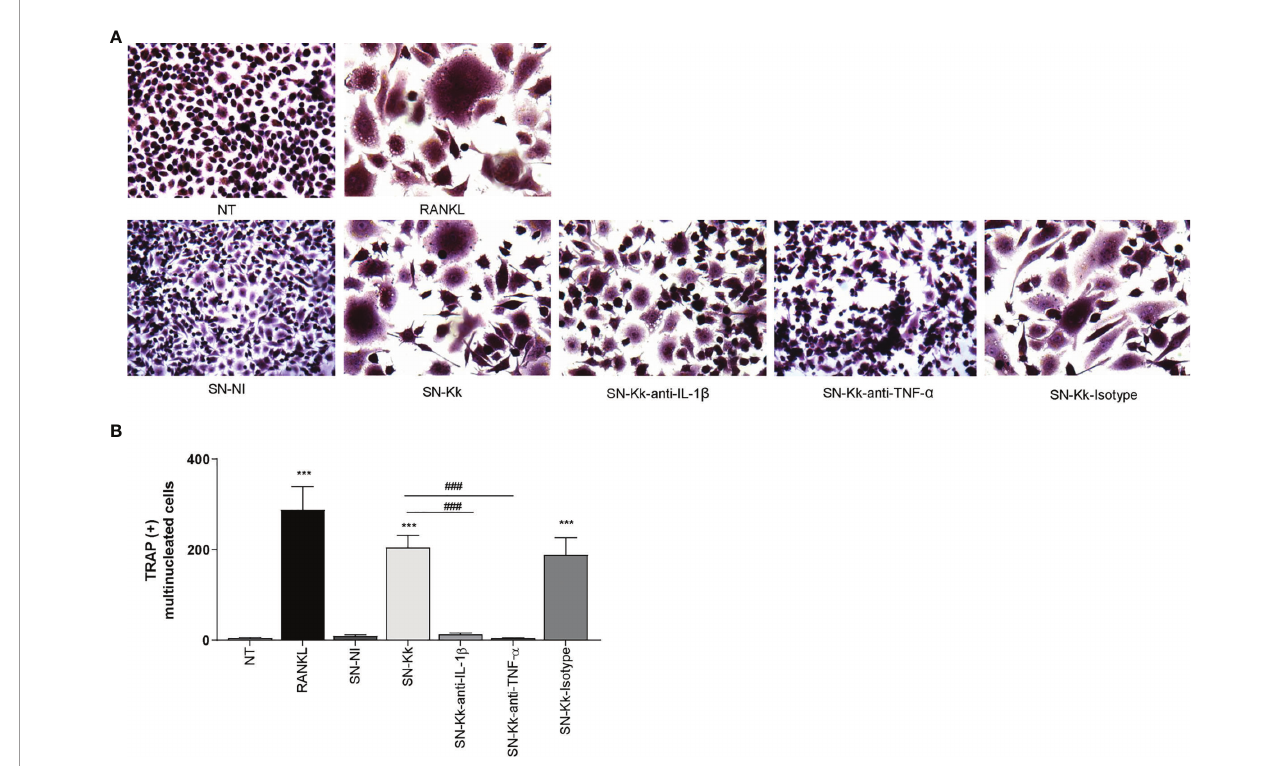
FIGURE 2 | Culture supernatants from Kingella kingae -infected monocytes induce osteoclast differentiation mediated by TNF- a and IL-1 b . Supernatants from K. kingae - infected THP-1 monocytes (multiplicity of infection = 1) induce RAW 264.7-derived osteoclastogenesis. RAW 264.7 cells were either untreated or stimulated with culture supernatants from K. kingae -infected THP-1 monocytes (SN-Kk) or with culture supernatants from non-infected THP-1 monocytes (SN-NI) added at a 1:2 proportion in conjunction with macrophage colony-stimulating factor. To inhibit TNF- a and IL-1 b , experiments were conducted in the presence of neutralizing antibodies. After 7 days, osteoclastogenesis was determined by the generation of TRAP-positive multinucleated cells (more than three nuclei). Representative digital images were taken by light microscopy (A) , and TRAP-positive multinucleated cells were identi fi ed and counted (B) . RANKL was used as a positive control. NT, non-treated. The graphics are showing values obtained from three independent experiments. Data are given as mean ± SD. *** P < 0.001 versus cells treated with SN-NI or NT. ### P <